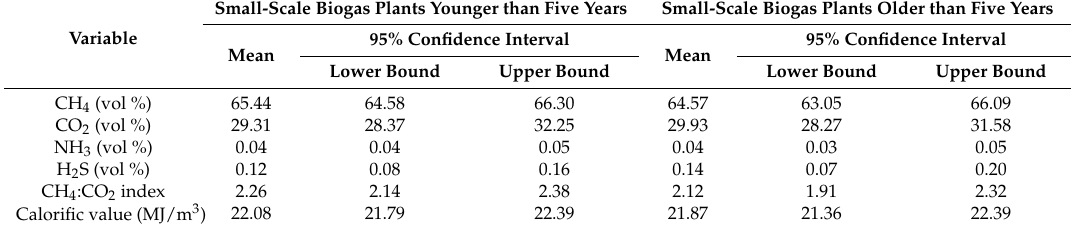
Table 5. Biogas composition from small-scale biogas plants younger than five years ( n = 82) and older than five years ( n = 25).